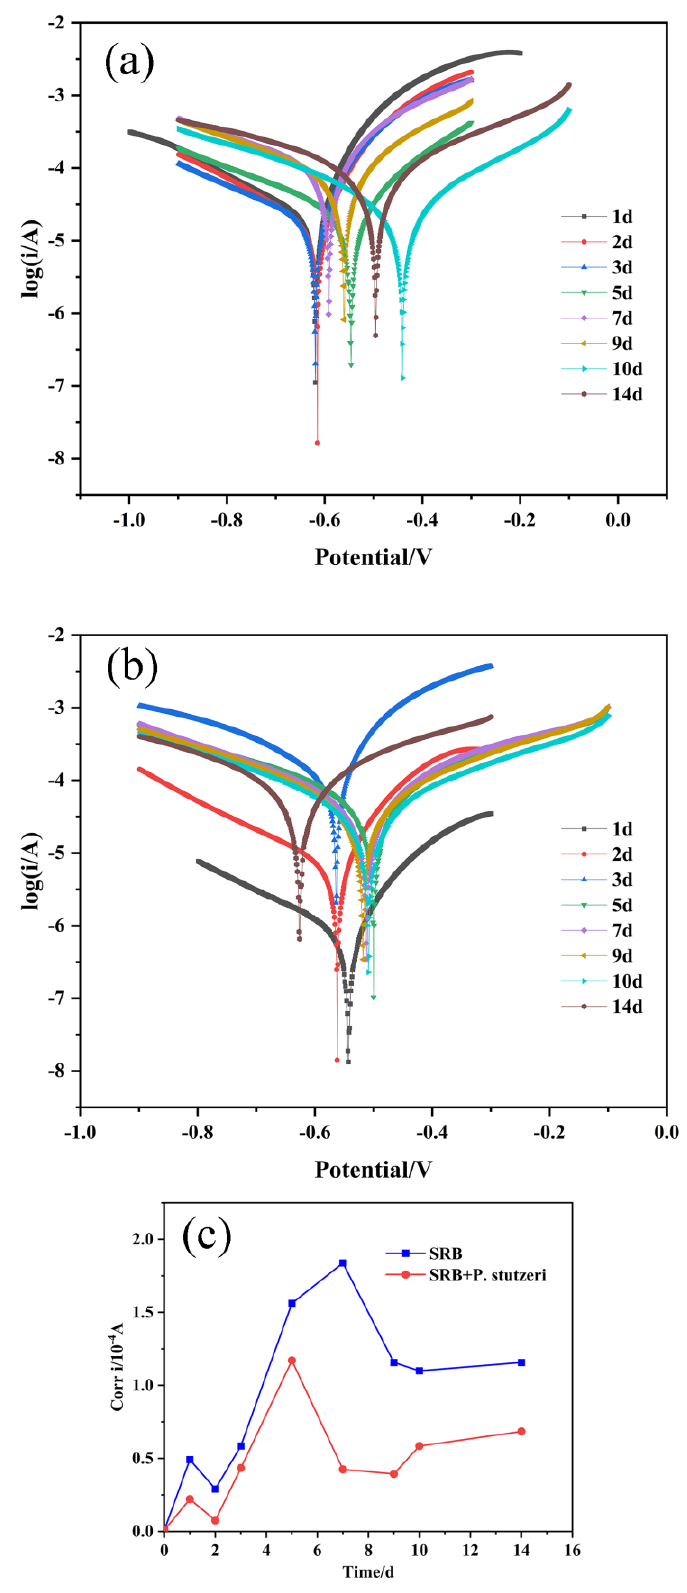
Figure 10. ( a ) The potentiodynamic polarization curves of SRB; ( b ) the potentiodynamic polarization curves of SRB + P. stutzeri ; ( c ) the corrosion current density.